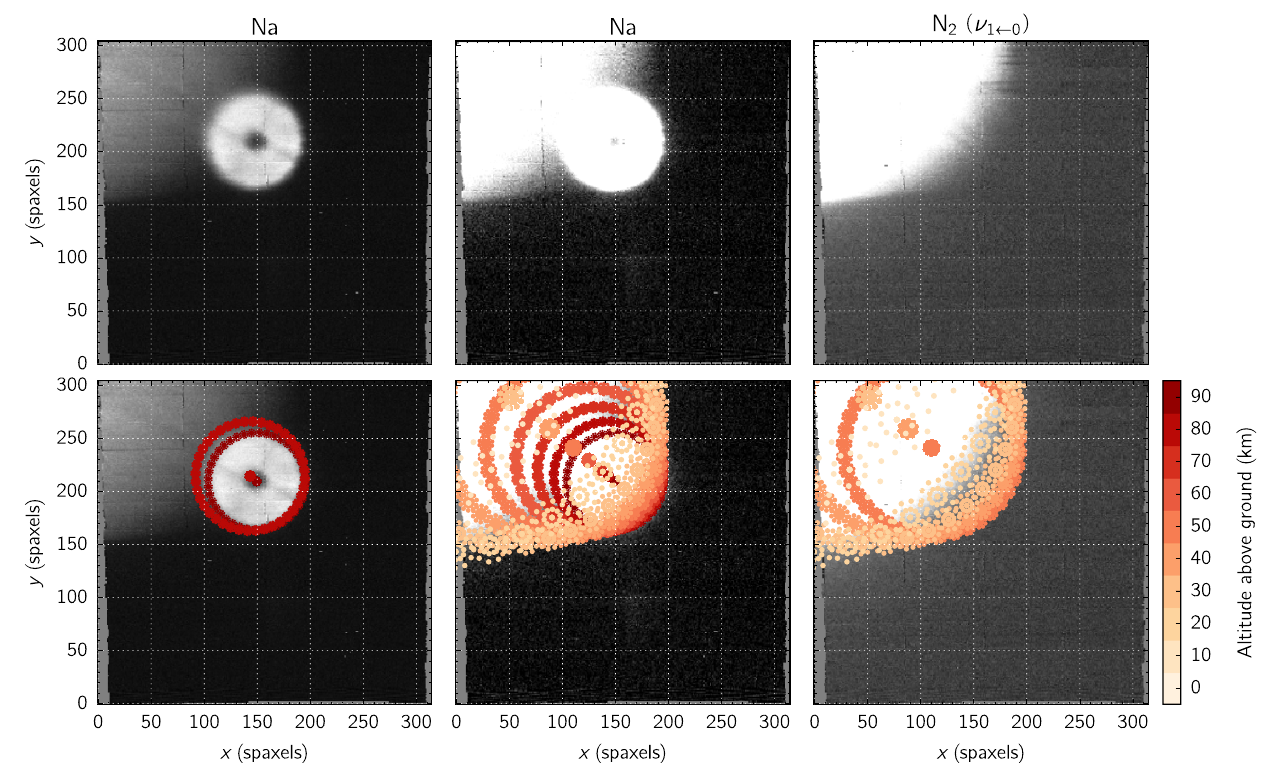
FIG. 10. Top panels: Summed MUSE slices within 4 Å from λ 4 (left panel; middle panel: contrast enhanced) and 6826.73 Å [ ≡ N 2 LGSF ( ν 1 ← 0 ); right panel] for an observation acquired with the LGS purposely located within the MUSE field of view. Bottom panels: Same as top, but with our modeled footprint of the laser beam as a function of the altitude overlaid (left panel: 80 km and 90 km; middle panel: 0 km – 90 km; right panel: 10 km – 50 km). The out-of-focus LGS donut size is well reproduced by the model, with a diffuse extension to the top left approximately matched by the 85-km layer, and consistent with the typical thickness of a few km of the sodium layer. The Rayleigh and Raman beams are best matched by the model out to altitudes of 30 (cid:2) 5 km above ground. Each starlike pattern in the modeled footprint of the 4LGSF beam (at a given altitude) is associated with one of our chosen sampling locations on the primary mirror — which, taken altogether, trace the spatial extent of the unresolved beam. A movie of the modeled beam footprint sampling the altitude in steps of 1 km is available in Ref.